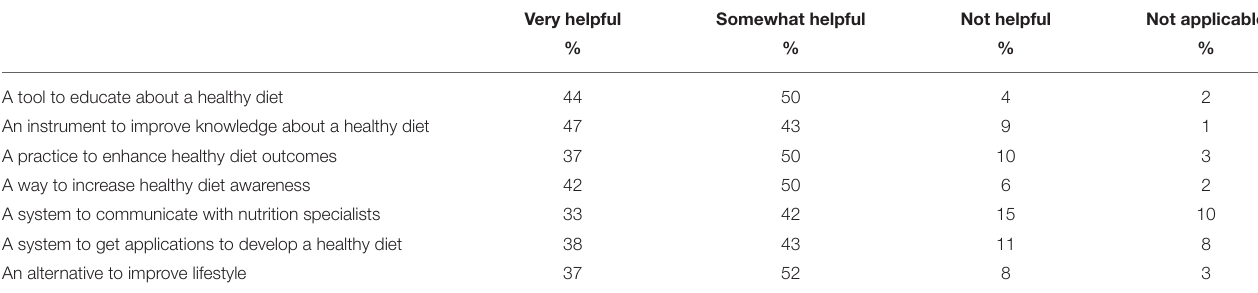
TABLE 3 | Usefulness of social media to manage a healthy diet ( n = 308).